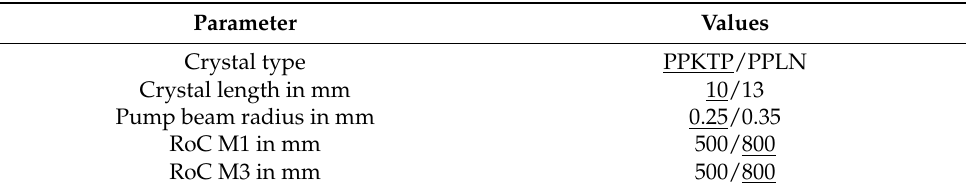
Table 4. Optimization parameters and possible values of the NesCOPO, the underlined parameters correspond to the best configuration (optimized output pulse